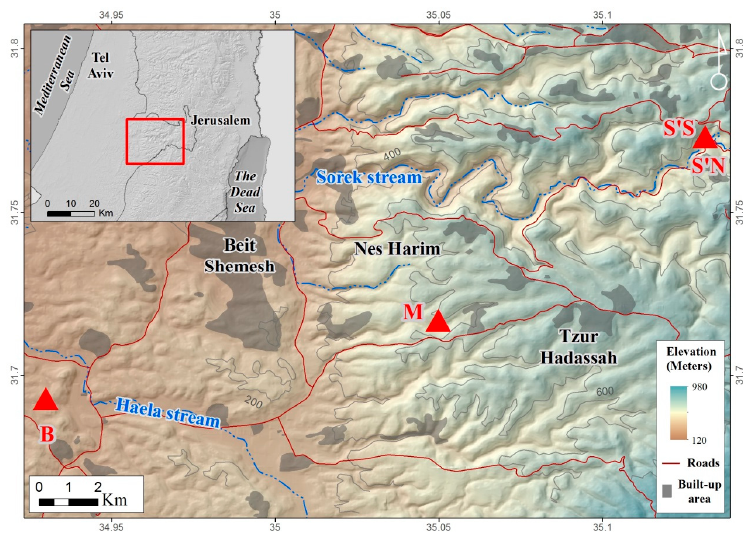
Figure 1. General map of the research sites. The grey lines represent elevation contours at vertical intervals of 100 m. The source of all elevation and vector data is the Survey of Israel database. Sites: B—Britanya park; M—Mata; S ′ S—Sataf, southern facing slope; S ′ N—Sataf, northern facing slope.